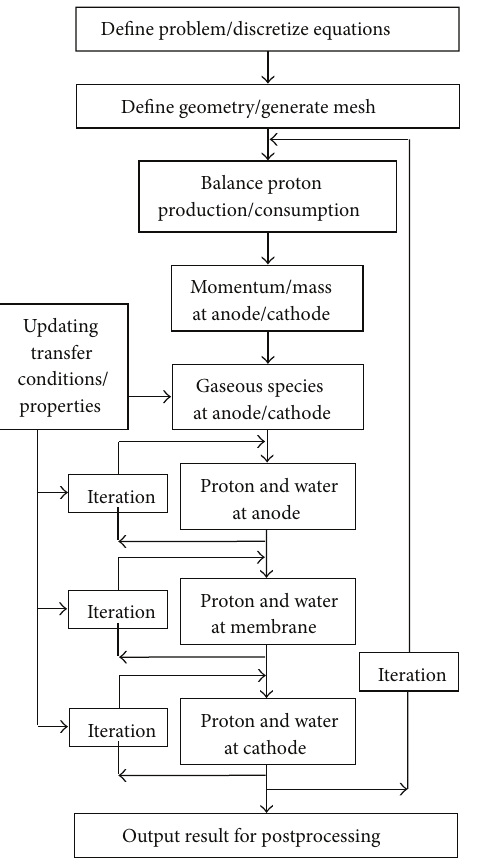
Figure 3: Modeling